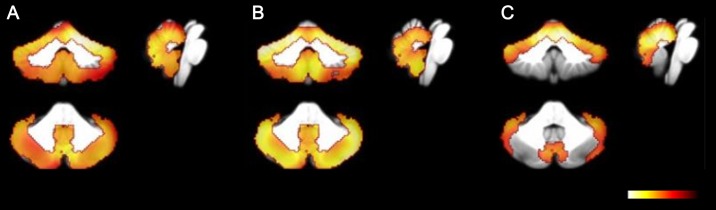
Coronal, sagittal, and transverse statistical parametric mapping images in patients with ataxia compared to normal controls (p < 0.001, FWE).Patients with multiple system atrophy of the cerebellar type (MSA-C, A) and spinocerebellar ataxia (SCA) type 2 (B) show decreased metabolism of the entire cerebellum. Patients with SCA type 6 (C) show decreased metabolism mainly in the anterior and superior posterior lobes of the cerebellum.